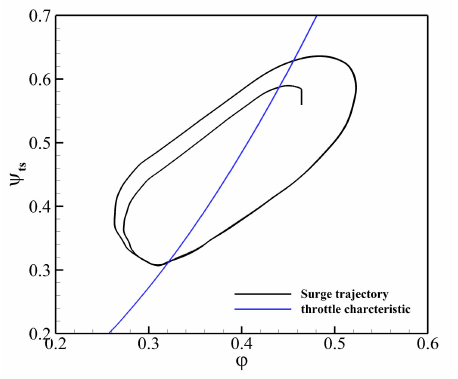
Figure 19. Dynamic process of surge for the